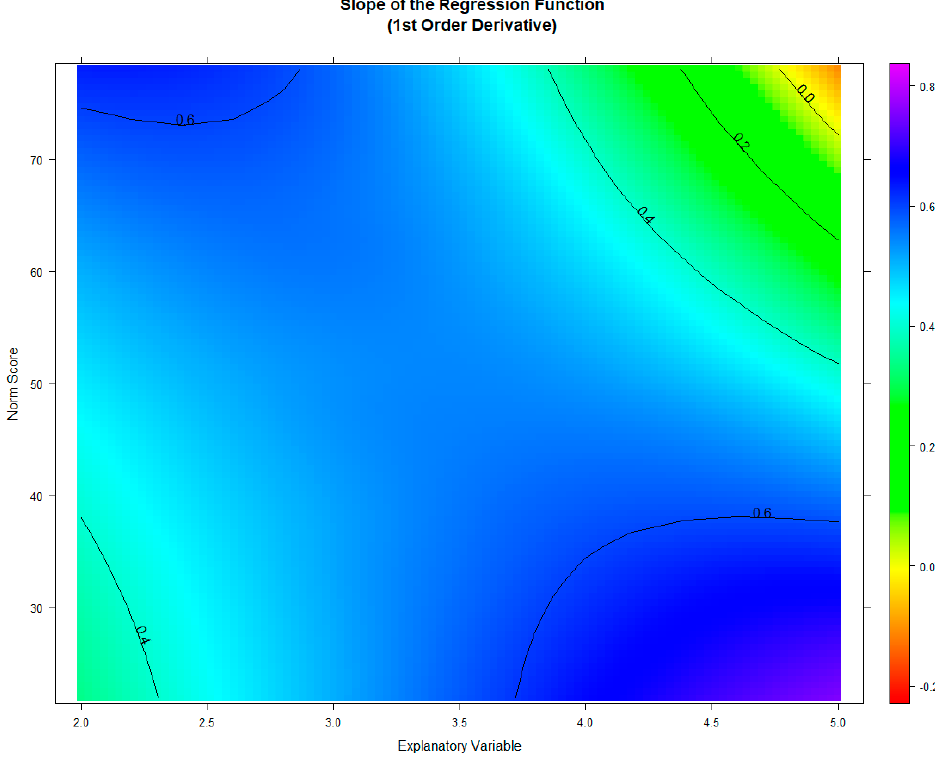
Figure 7. Derivative of the regression function.